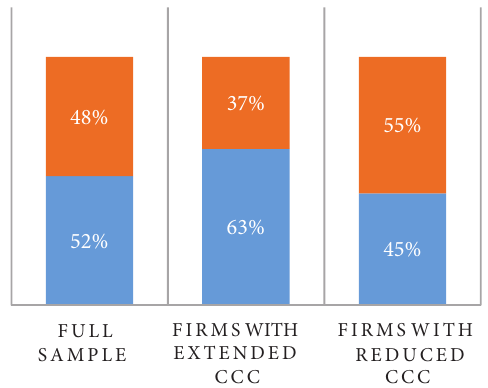
Figure 1. Short-term borrowings and Profitability under the influence of